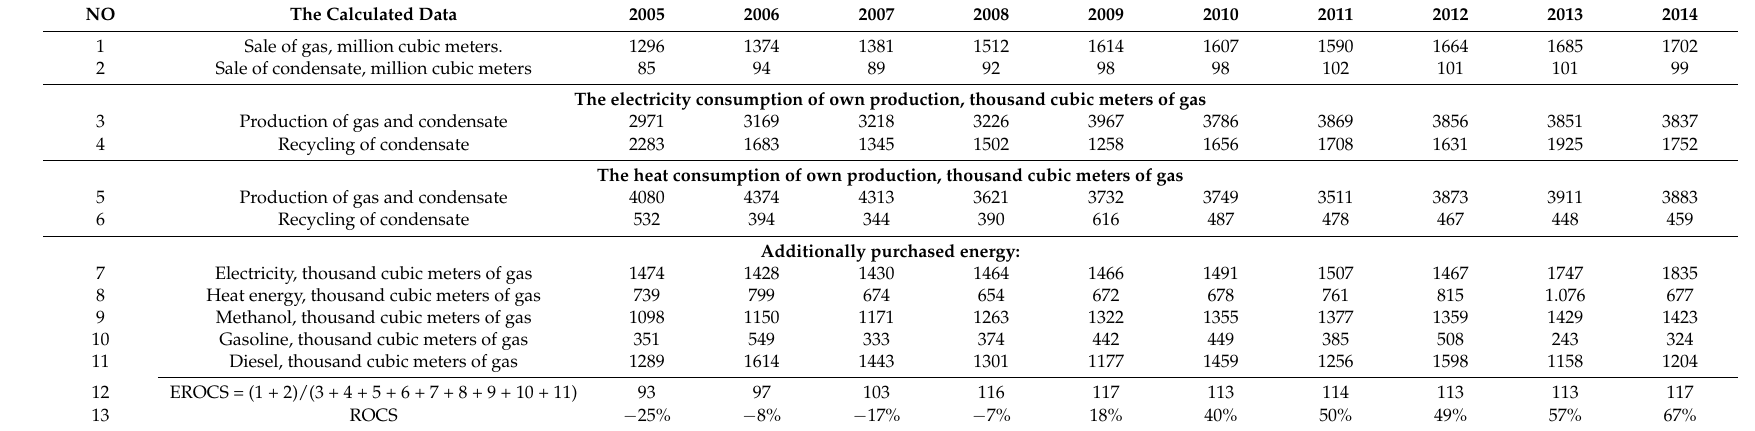
Table A3. Dynamics of indicators of ROCS and EROCS in JSC Yakutsk